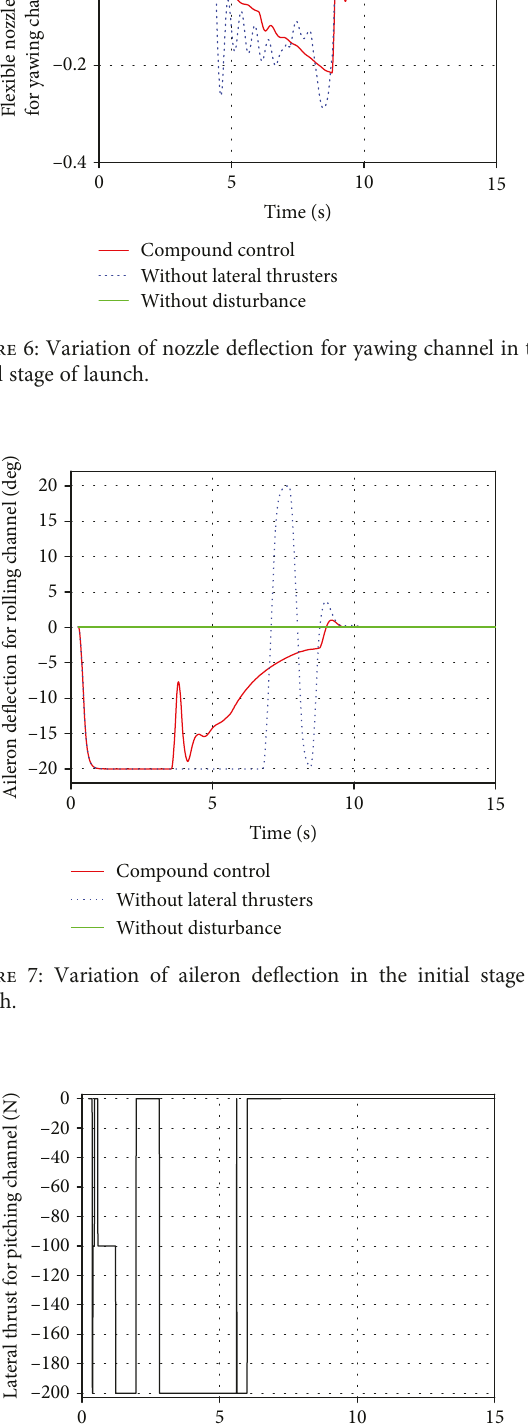
in the initial stage of launch. y